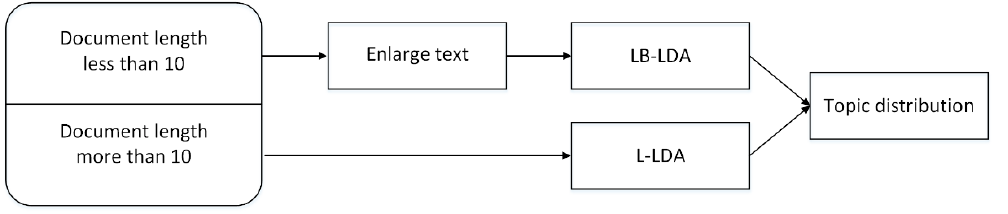
Figure 10. The process of obtaining topic distribution.